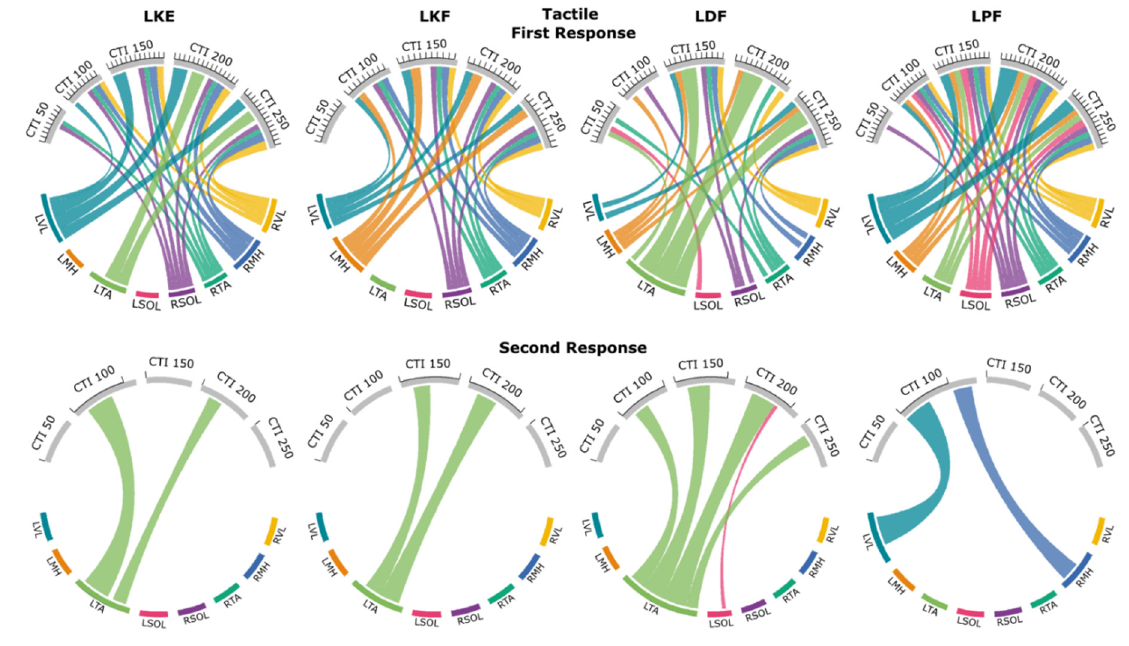
Figure 5. Excitability and inhibitory interactions during left knee extension (LKE), left knee flexion (LKF), left dorsiflexion (LDF) and left plantarflexion (LPF) movements using tactile cues: averaged significant ( p < 0.05) facilitation or inhibition during first ( top ) or second ( bottom ) responses during tactile cues. Each first response is scaled to the control condition where control is 100% and corresponds to the distance between tick marks. Second responses are given as the ratio between second and first response for that pair of responses. Individual muscles are grouped along the bottom of each plot. Thickness of connections denotes the amount of inhibition or facilitation found where significant inhibition is designated with a circled minus sign.